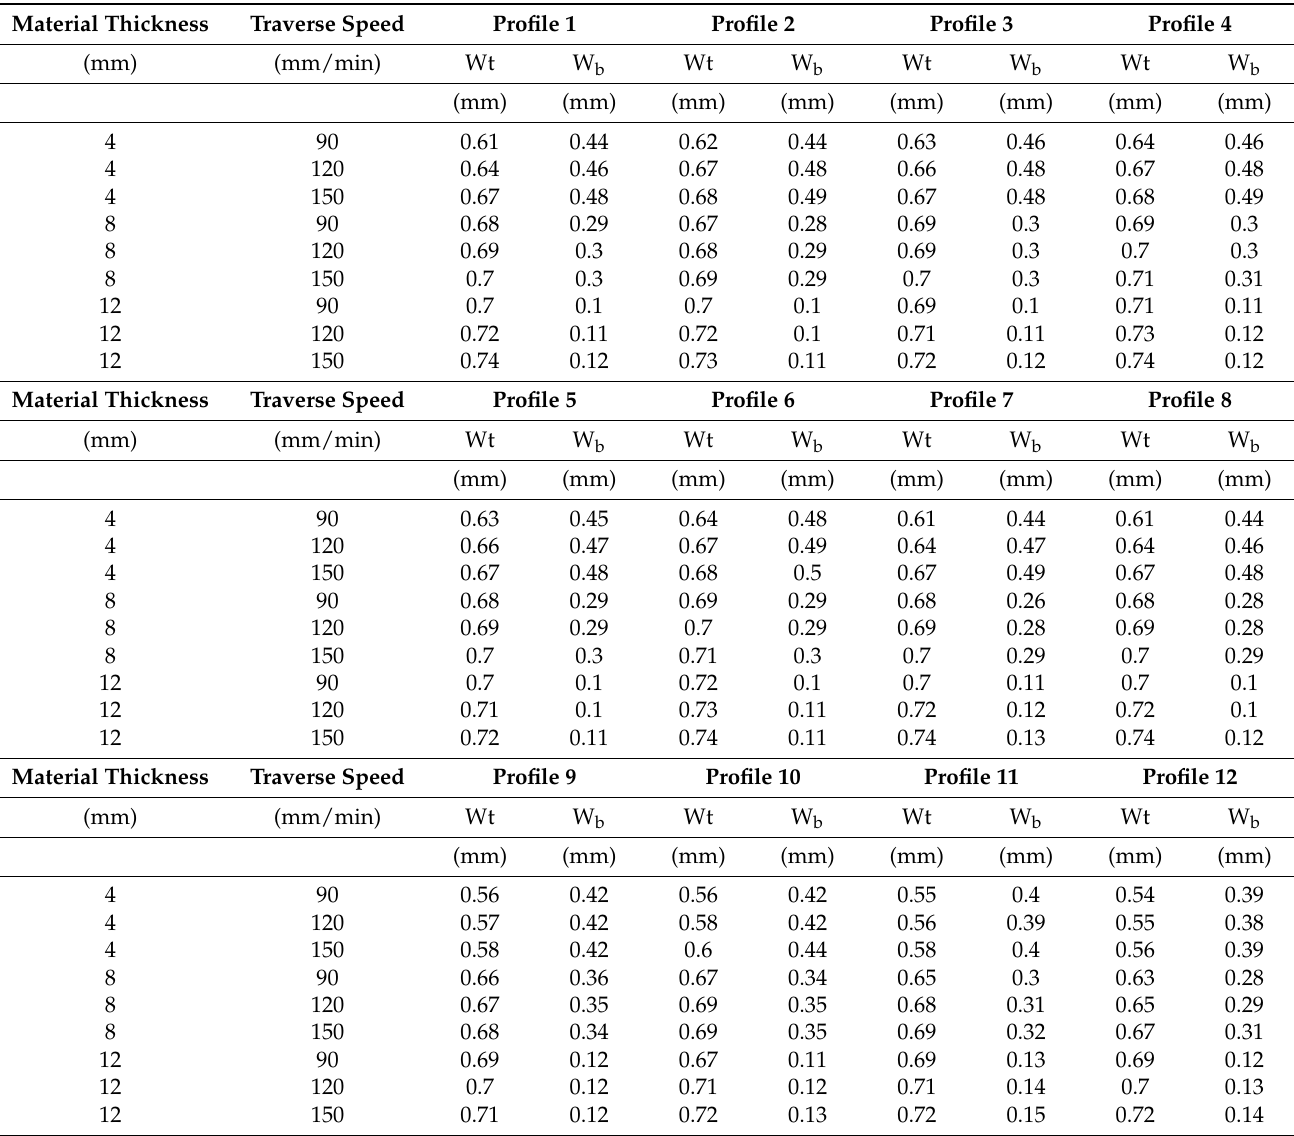
Table A1. Kerf top width and kerf bottom width